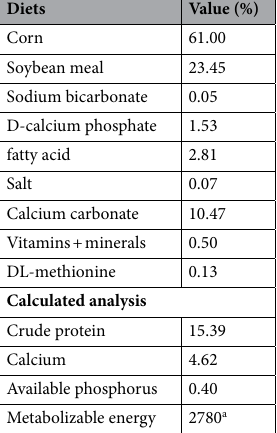
Table 2. The Ingredients (%) and nutrient composition of the diet. a